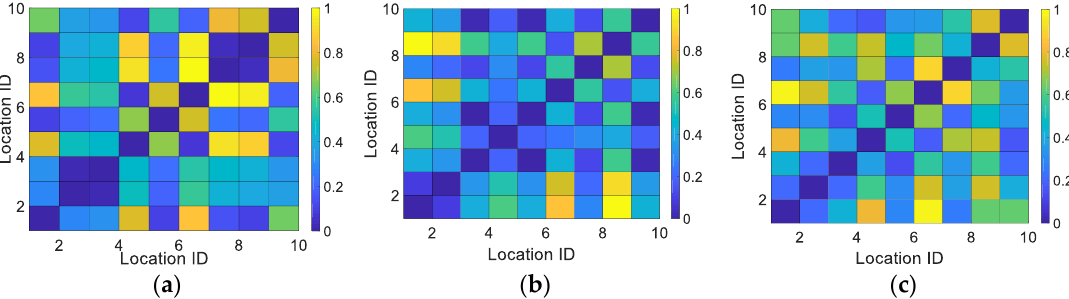
Figure 7. Confusion matrixes of normalized Euclidean distance. ( a ) light signal; ( b ) magnetic signal; ( c ) light and magnetic signal.